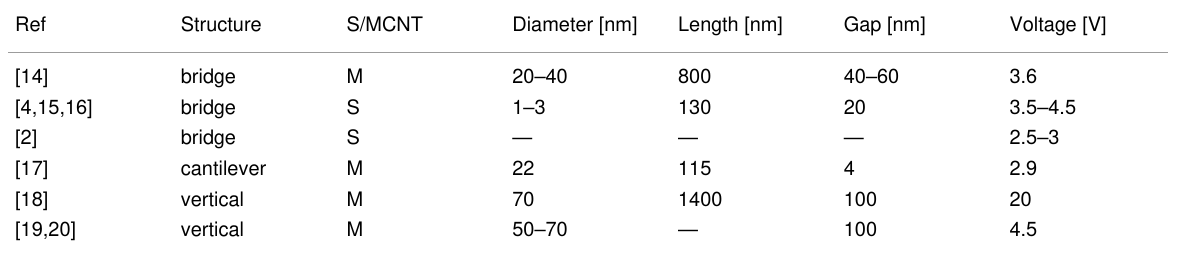
Table 1: Structures and pull-in voltages of CNT switches.